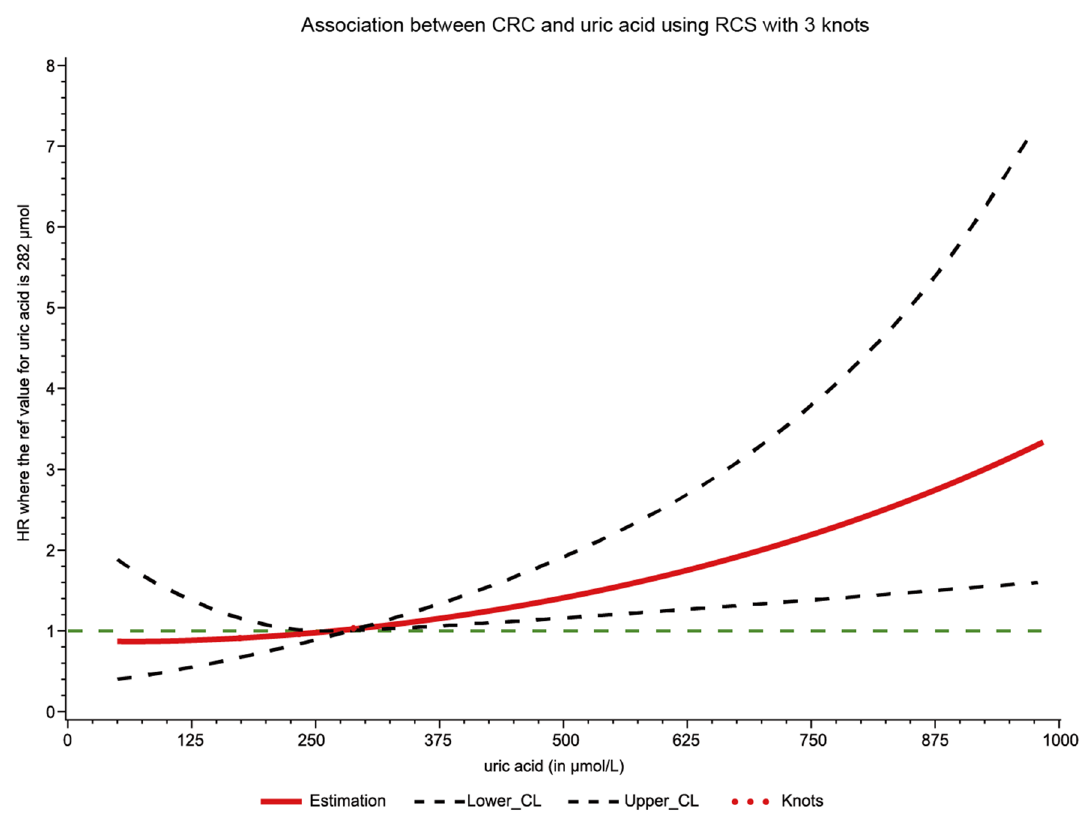
Figure 2. Association between SUA and CRC risk using RCS with 3 knots. Cubic spline graph of the adjusted HR (represented by solid line) and 95%CI (represented by the dotted